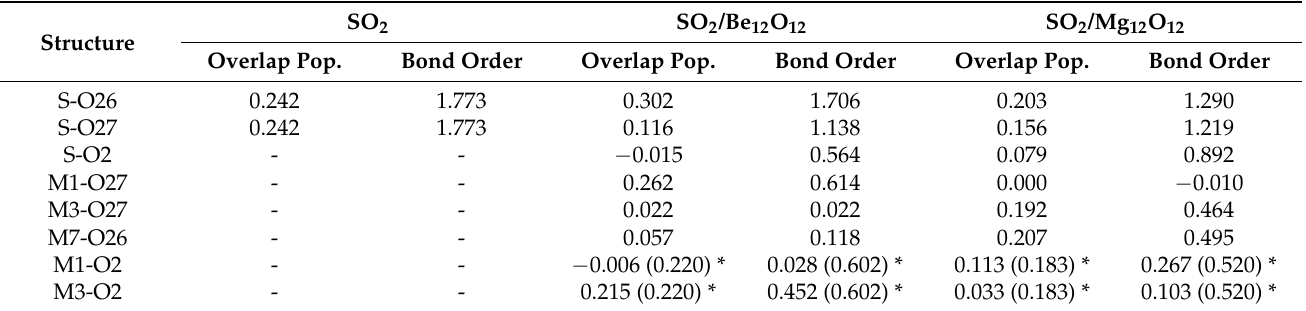
Table 6. Overlap population and bond order of SO 2 , SO 2 /Be 12 O 12 , and SO 2 /Mg 12 O 12 .